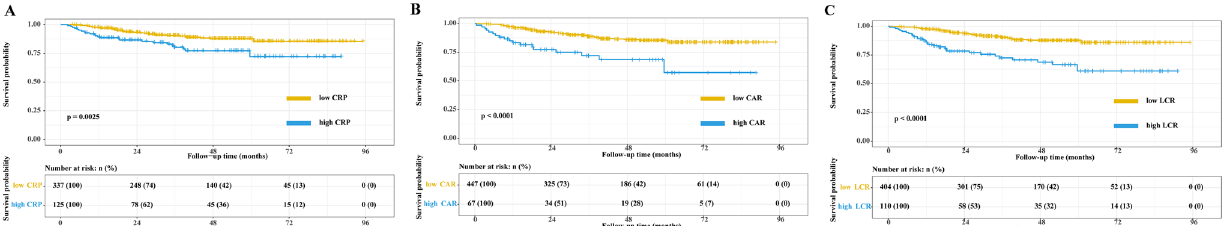
Figure 4. The Kaplan–Meier survival curves of systemic inflammatory indicators in women with breast cancer. ( A ) CRP; ( B ) CAR; ( C ) LCR. Notes CRP C-reactive protein, LCR lymphocyte to C-reactive protein ratio, CAR C-reactive protein to albumin